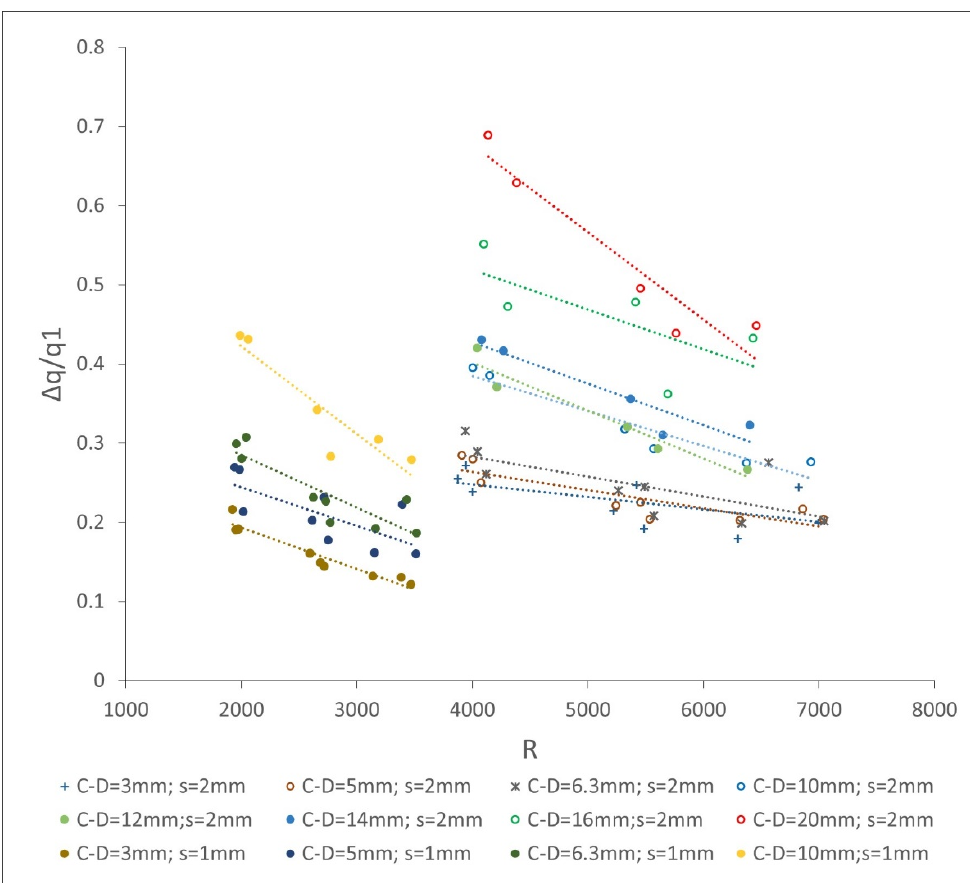
Figure 17 . Relations for circular wire screen between Δ q / q 1 and Reynolds number . Figure 17. Relations for circular wire screen between ∆ q / q 1 and Reynolds